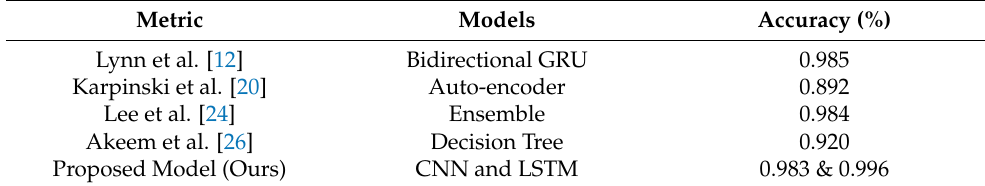
Table 3. Comparison of the proposed method with other SOTA methods.